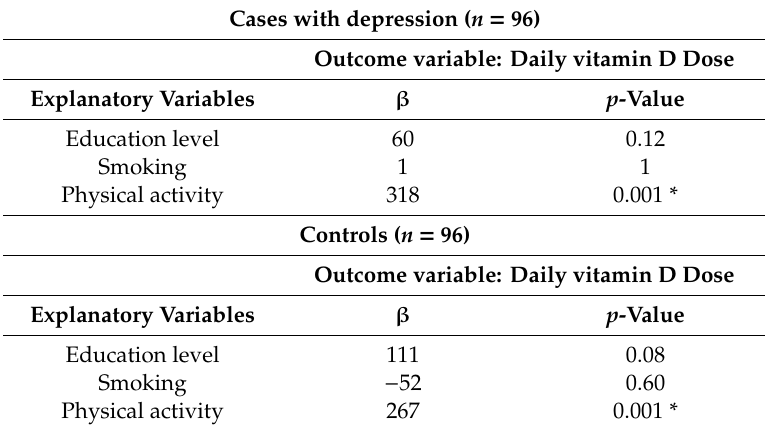
Table 3. Association * between total vitamin D doses and selected predictors. Cases with depression ( n = 96)